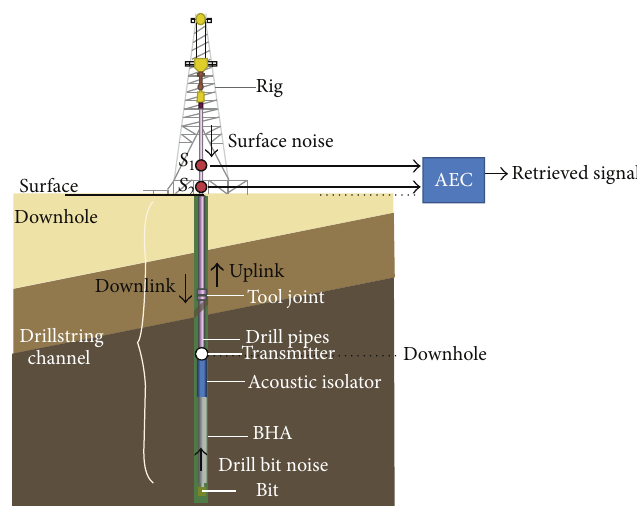
Figure 1: Schematic view of the proposed model.